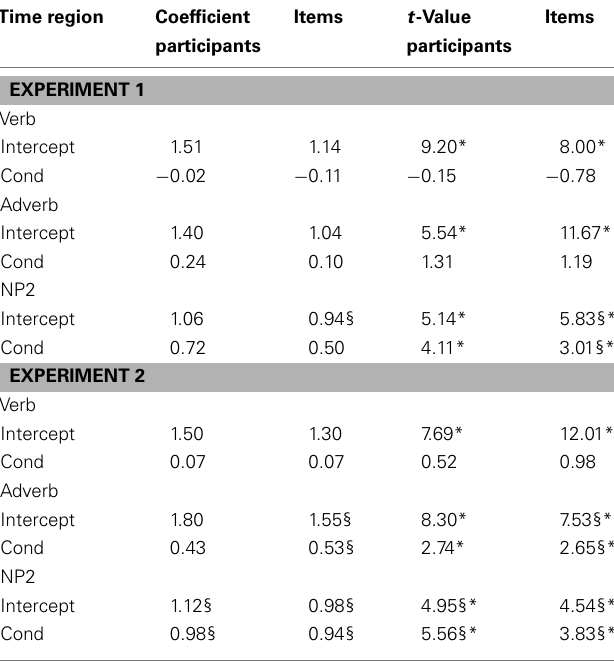
Table 3 | Linear mixed effect model results for Experiments 1 and 2 by time region.